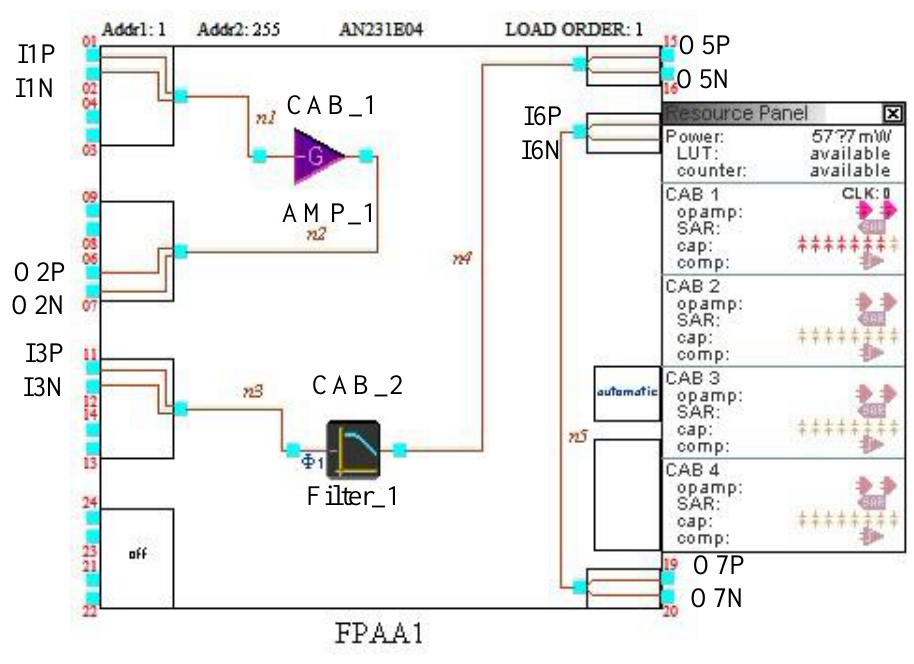
Figure 12. Circuit configuration of the FPAA in the normal